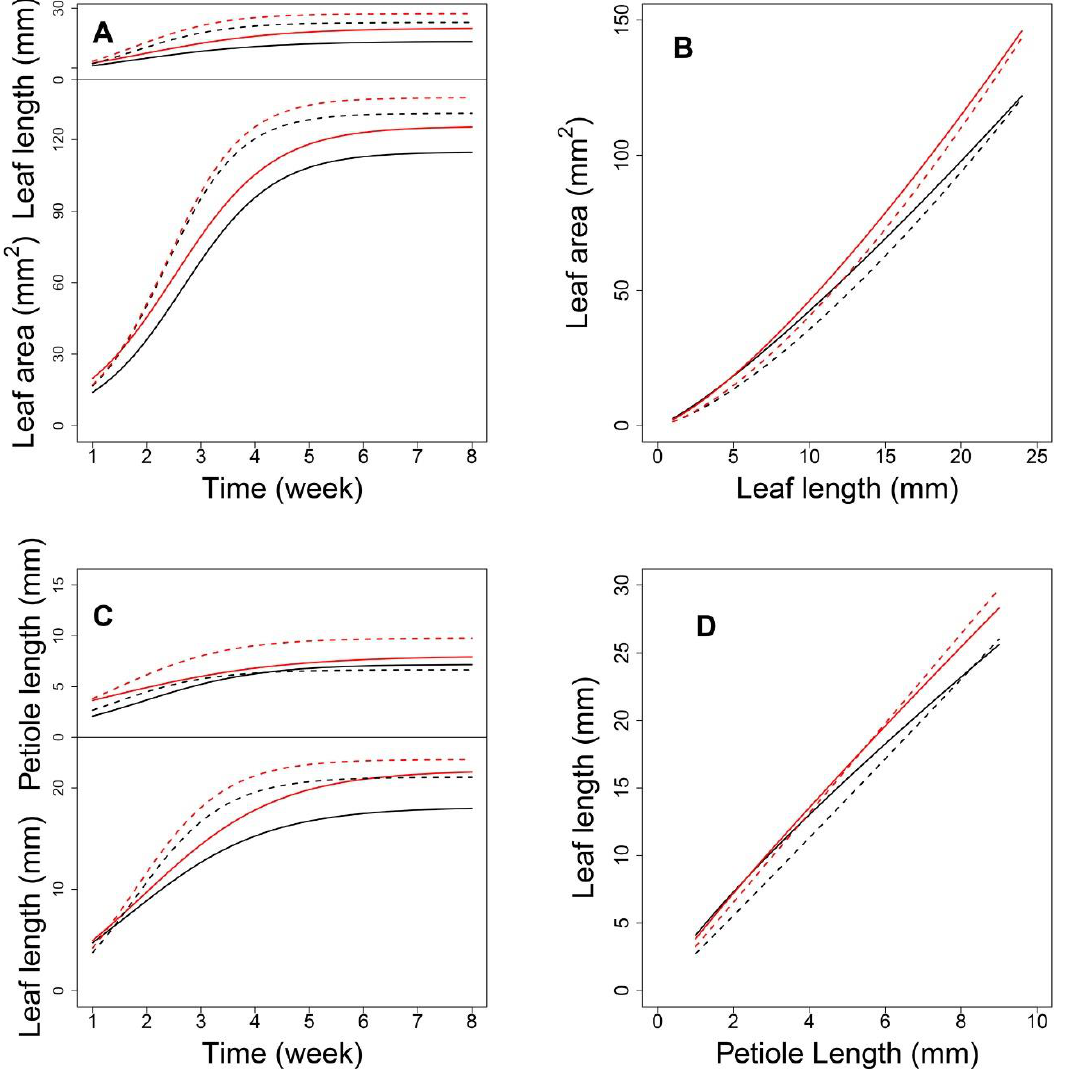
Figure 7. Expression patterns of pleiotropic QTL. With QTL located at AT1G10240.1, ( A ) shows the ontogenic growth curve of leaf length and leaf area, and ( B ) shows their allometry growth curve. ( C ) shows the ontogenic growth curve of petiole length and leaf length, and ( D ) shows their allometry growth curve. The solid line represents low density, the dotted line represents high density, and red and black color express different genotypes with the